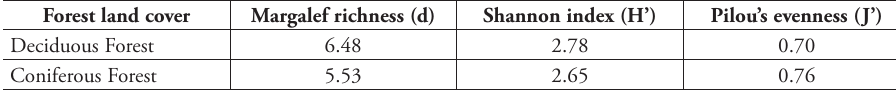
Table 6. Diversity indices in deciduous and coniferous forest headwater